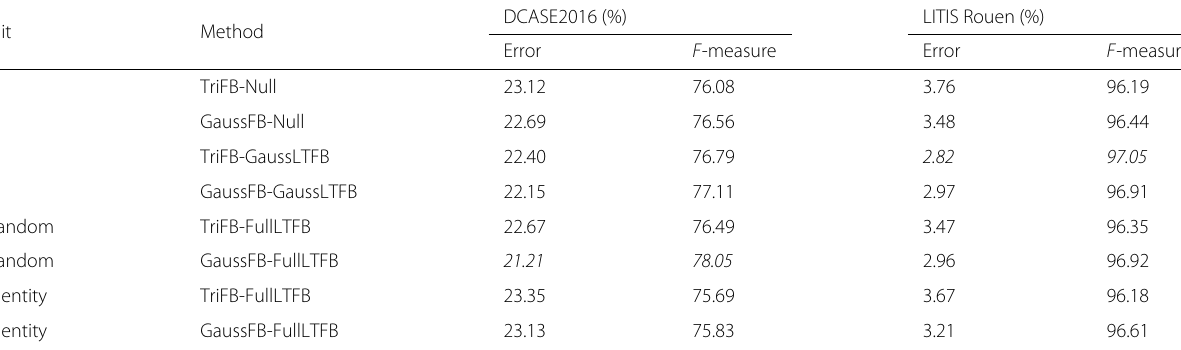
Table 4 Average performance comparison using different configurations on LITIS Rouen dataset and DCASE2016 dataset Init